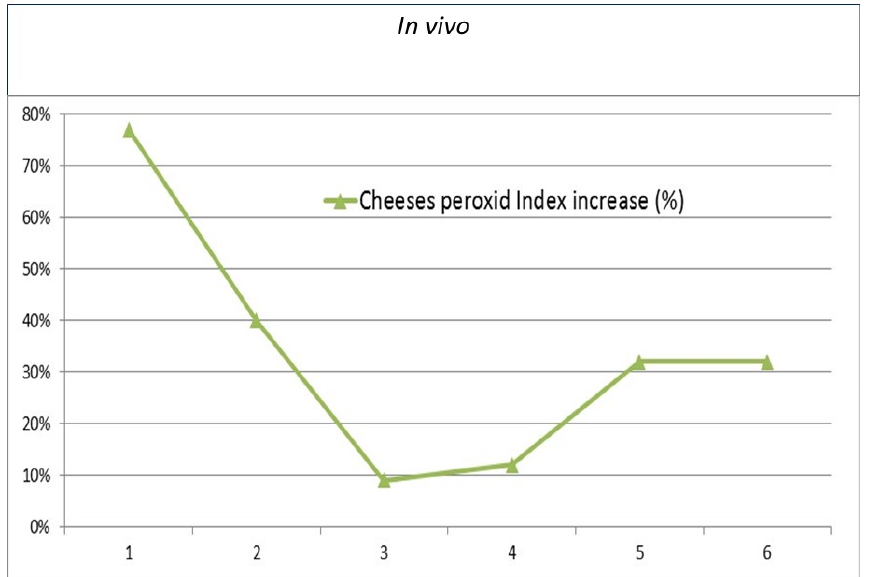
Figure 1. Coated cheeses’ (assays 1–6) peroxide index increase (%) after 9 days-storage indicating the in vivo antioxidant protection of the active coatings.